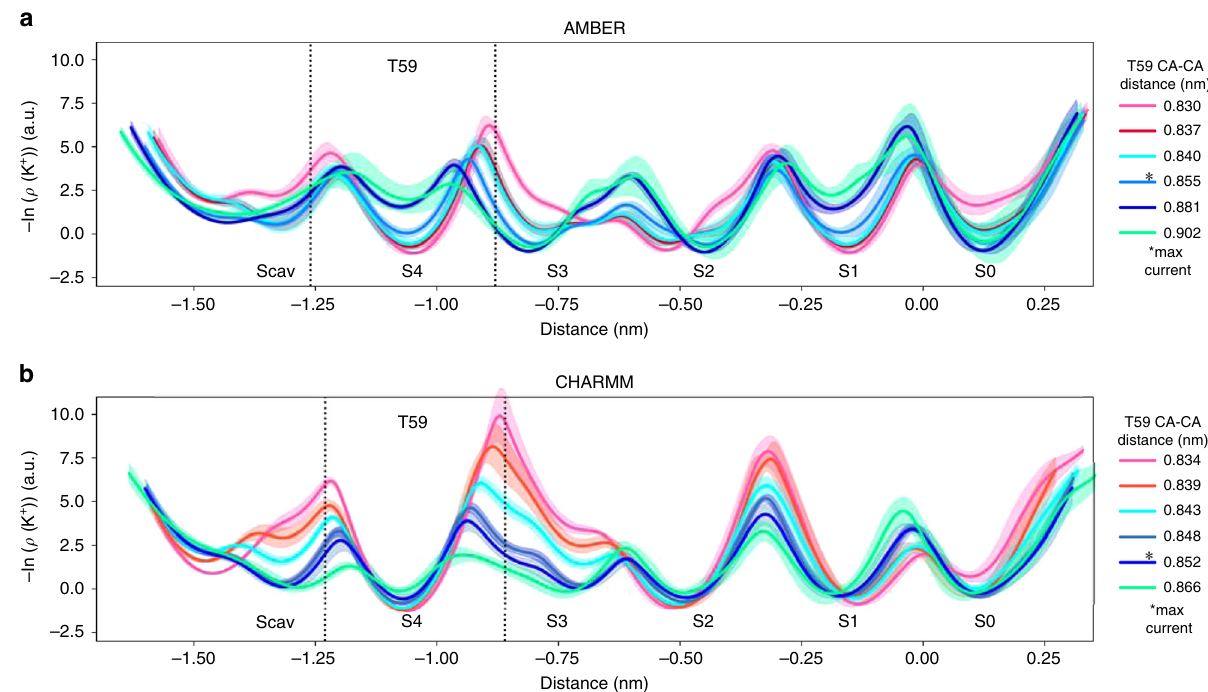
Fig. 3 Negative logarithmic densities of K + ions inside the SF of MthK. Densities can be treated as approximate free energy pro fi les with minima corresponding to ion binding sites and maxima being energy barriers between them. Data for several levels of opening are presented from the main set of simulations (restrains applied to the ends of TM helices), for both a AMBER and b CHARMM force fi elds, as a function of distance along the SF main axis. Colors represent opening levels and correspond to Fig. 1. C — pink/red: non-conductive (closed) channels; cyan/blue: open channels; green: maximally open channels. Openings for which the highest outward K + current was recorded are marked with *max current. Error bars represent 95% con fi dence intervals. Source data are available as a Source Data fi le.